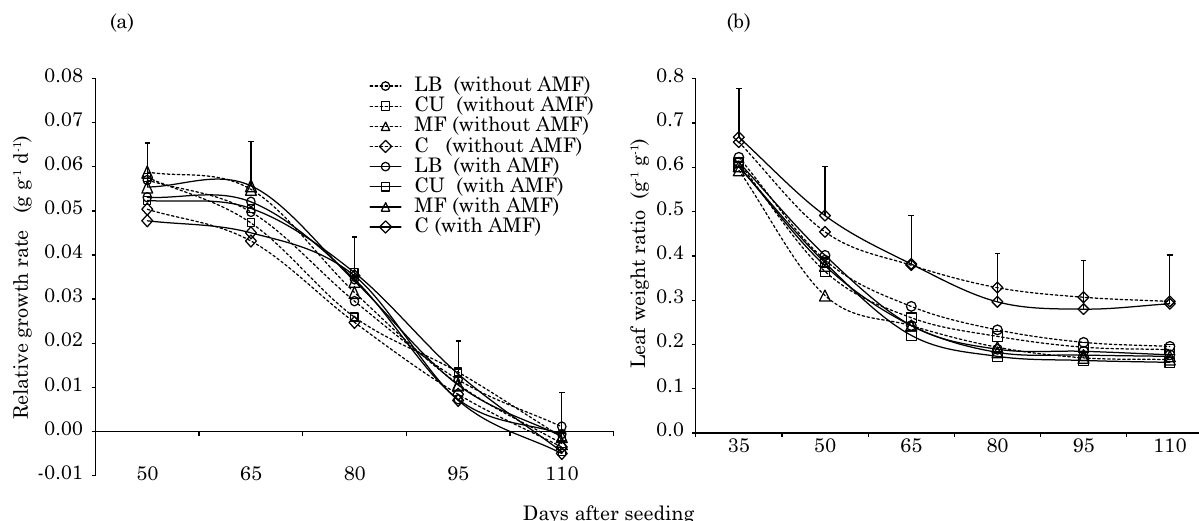
Figure 2. Relative growth rate (a) and leaf weight ratio (b) of sunflower as a function of fertilization treatments. Vertical bars indicate LSD 0.05 for fertilization treatments within each time under